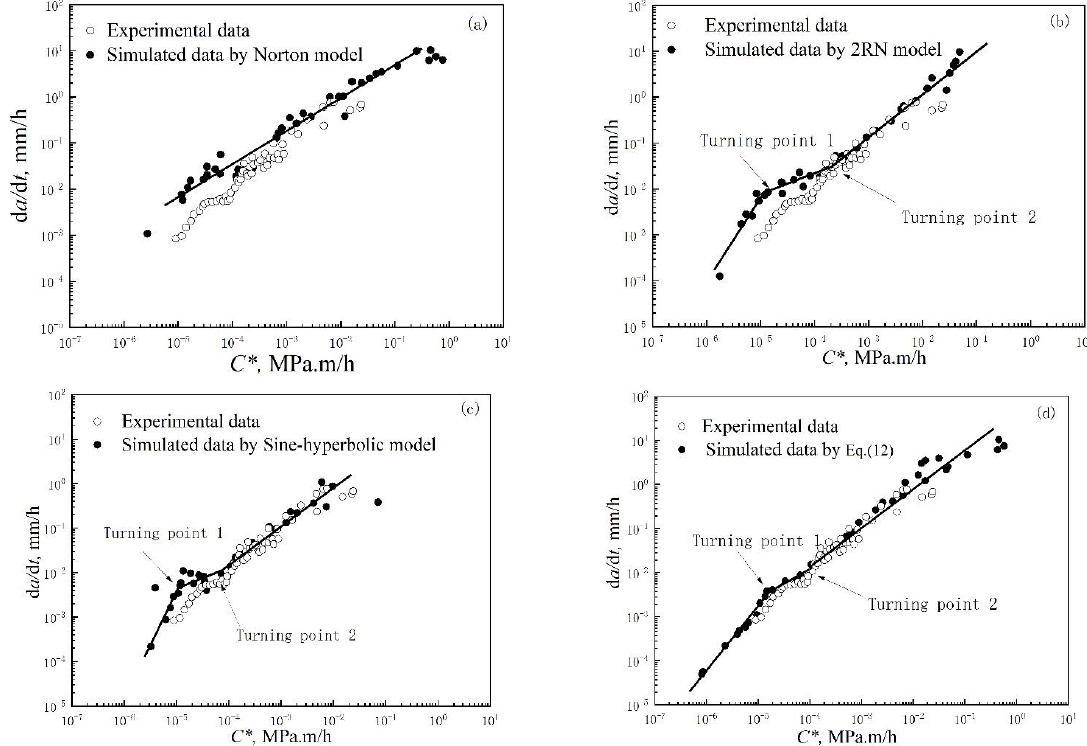
Figure 10. The da/dt-C* correlation curves calculated by: the Norton model ( a ), the 2RN model ( b ), the sine-hyperbolic model ( c ) and the Equation (12) constitutive model ( d ) in a wide range of C* and a comparison with the experimental da/dt-C* curves [5].